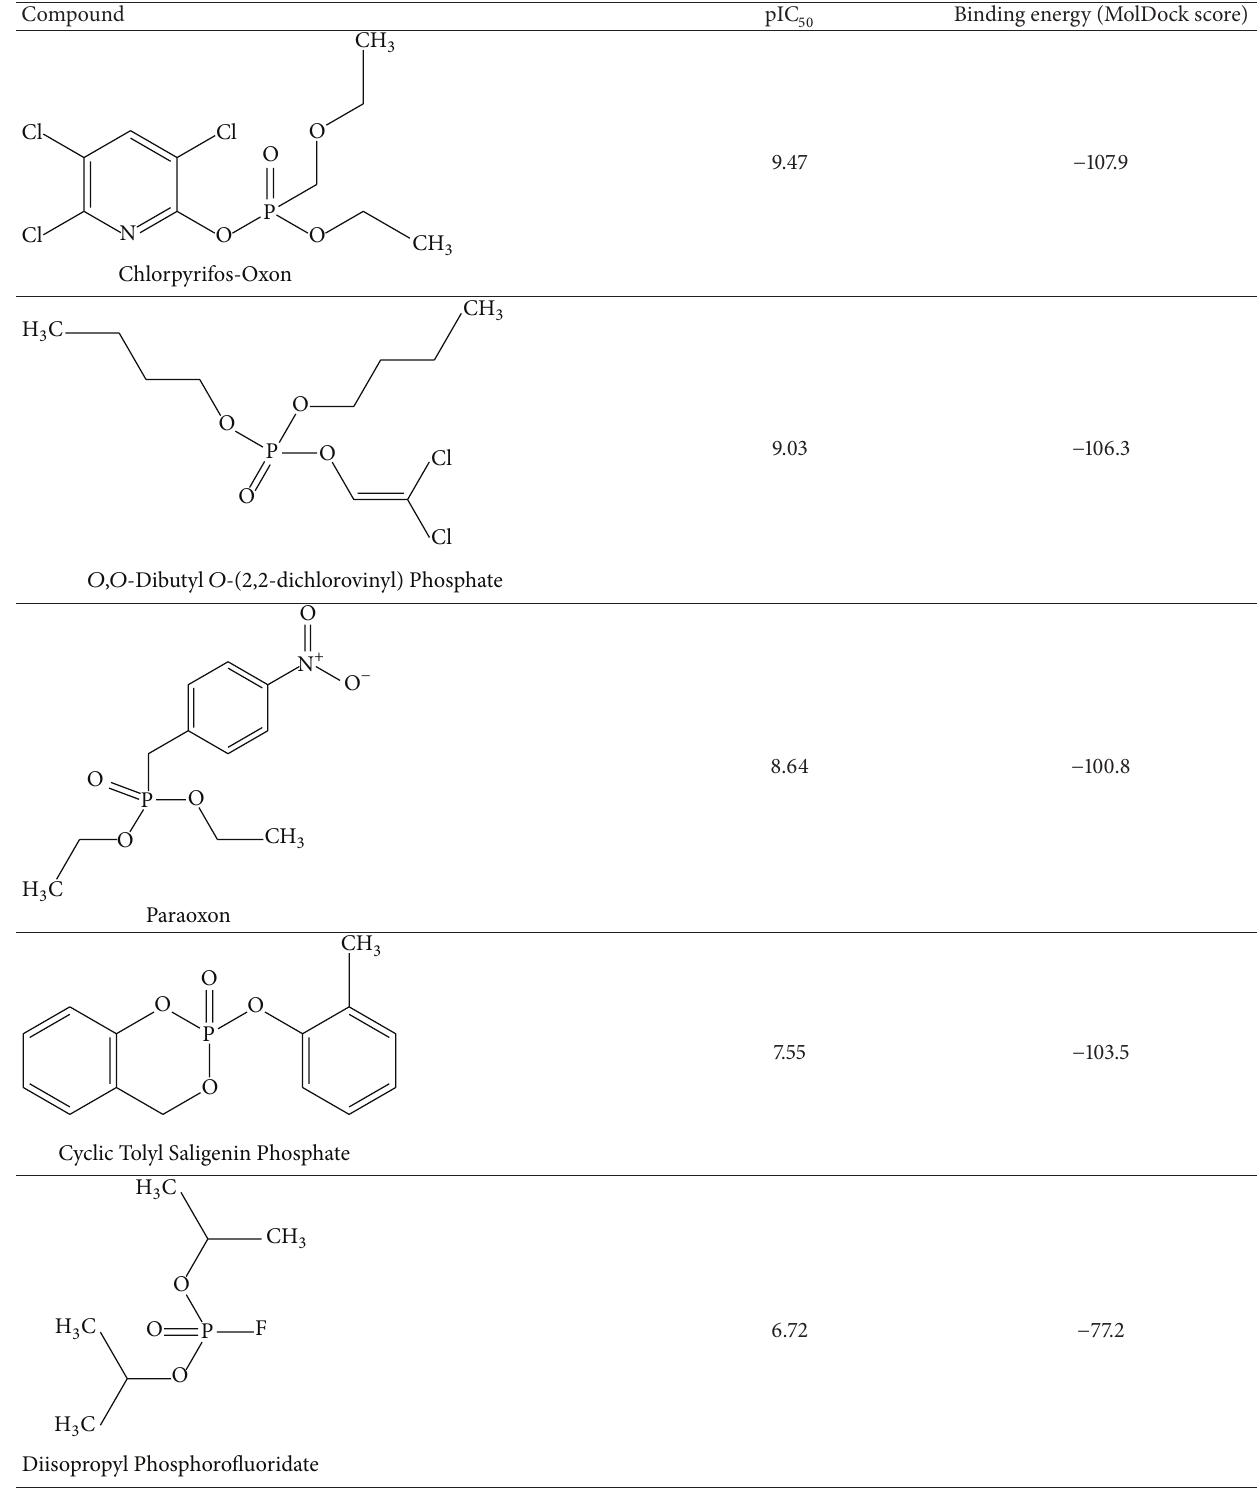
Table 2: Group of organophosphorus compounds used as parameters, with structure and name, pIC 50 ( − logIC 50 (mol/L)), and binding